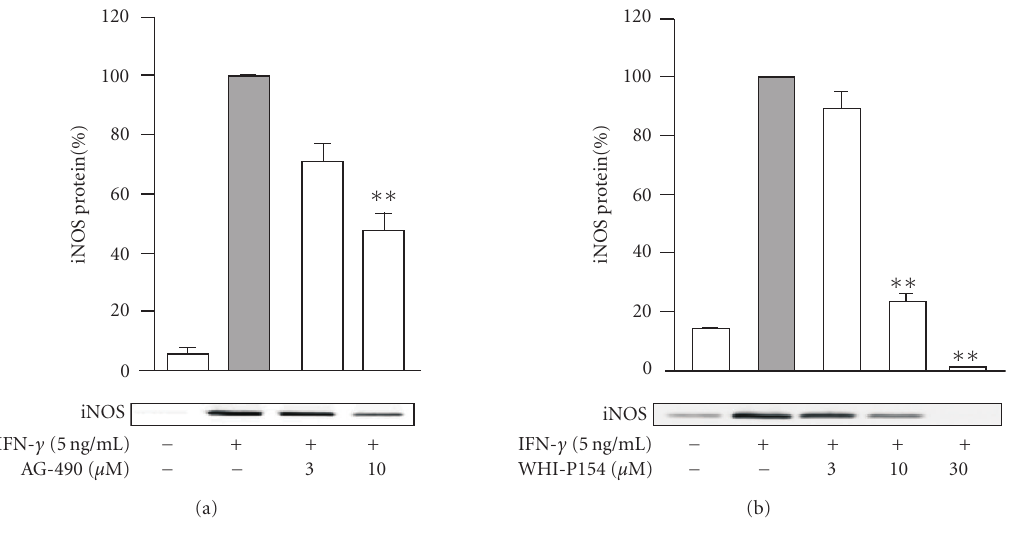
Figure 4: E ff ects of (a) AG-490 and (b) WHI-P154 on iNOS protein expression in J774 macrophages. Cells were incubated with IFN- γ (5ng/mL) in the presence or in the absence of the tested compound for 24hours. Cells were lysed and the protein content of the lysates was measured, and equal amounts of proteins (20 μ g) were subjected to immunoblot analysis with an antibody against iNOS. The results are shown as mean ± SEM ( n = 6 for AG-490 and n = 4 for WHI-P154), ∗∗ P < . 01 when compared to cells treated with IFN- γ